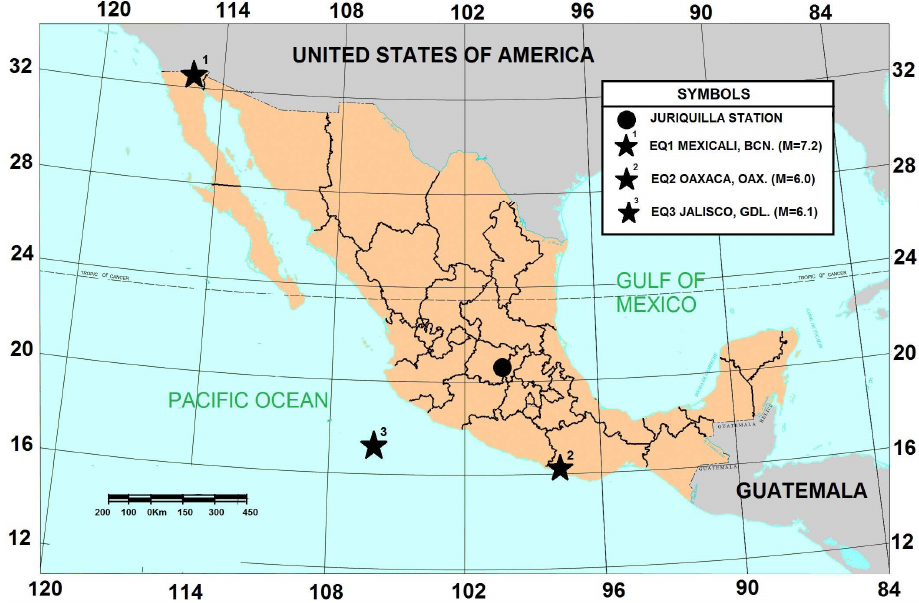
Fig. 1. The relative location of the geomagnetic observatory, Juriquilla (JU2) and three EQs (indicated by black stars) occurring during the 2010 year.